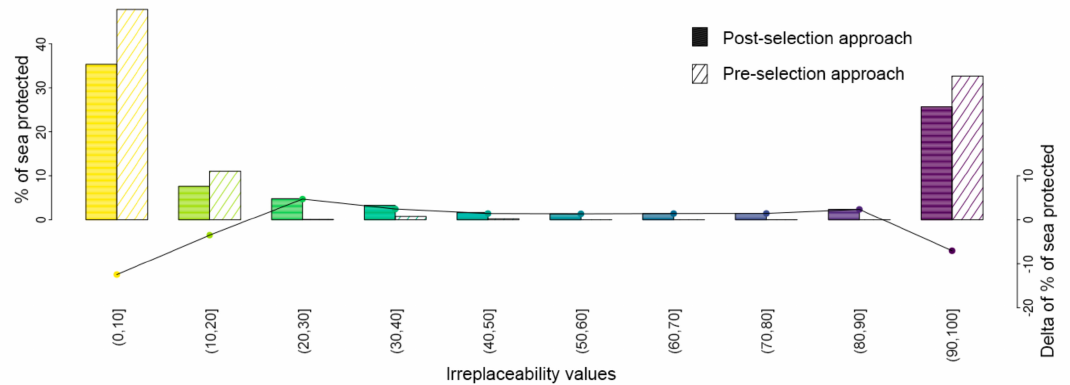
Figure 3. Frequency distributions of priority ranking values derived from the two approaches used for integrating species distribution uncertainties. Bars of full color represent the result of the post- selection approach coupled with exact optimization, hatched bars represent the result from the pre-selection approach coupled with heuristics. The curve represents the frequency differences across different levels of priority between the two